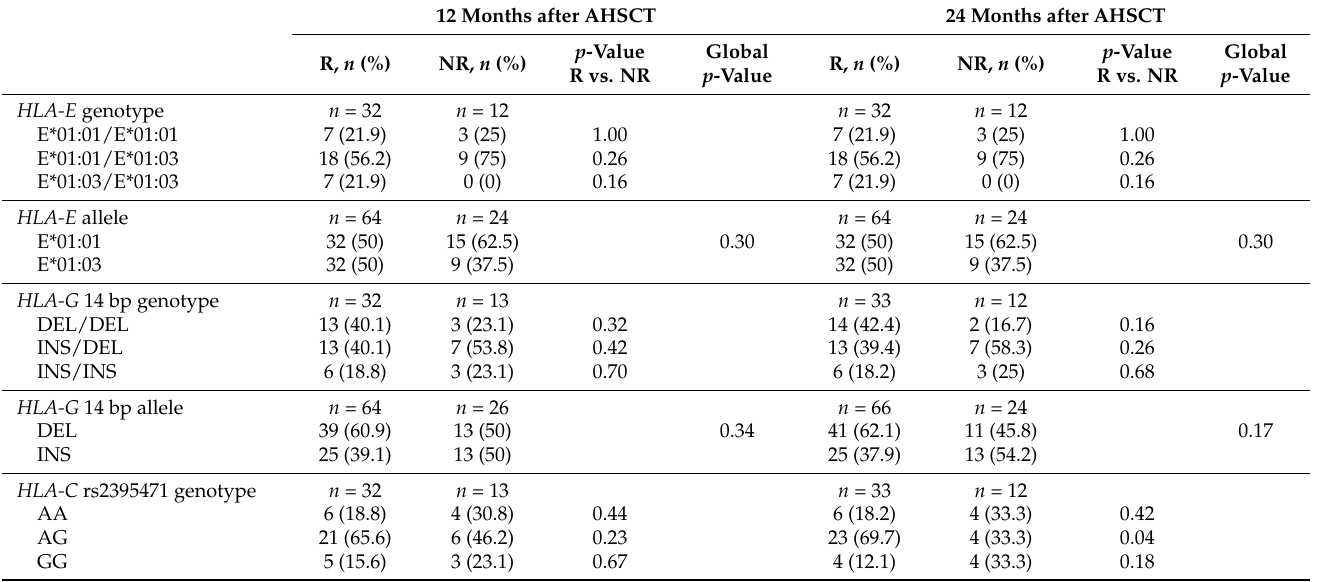
Table 3. Genotype distributions and allele frequencies of HLA-E and G and the imputed HLA-B and C polymorphisms in Systemic Sclerosis patients, according to the observed clinical response (respon- der or non-responder) 12 and 24 months after autologous hematopoietic stem cell transplantation